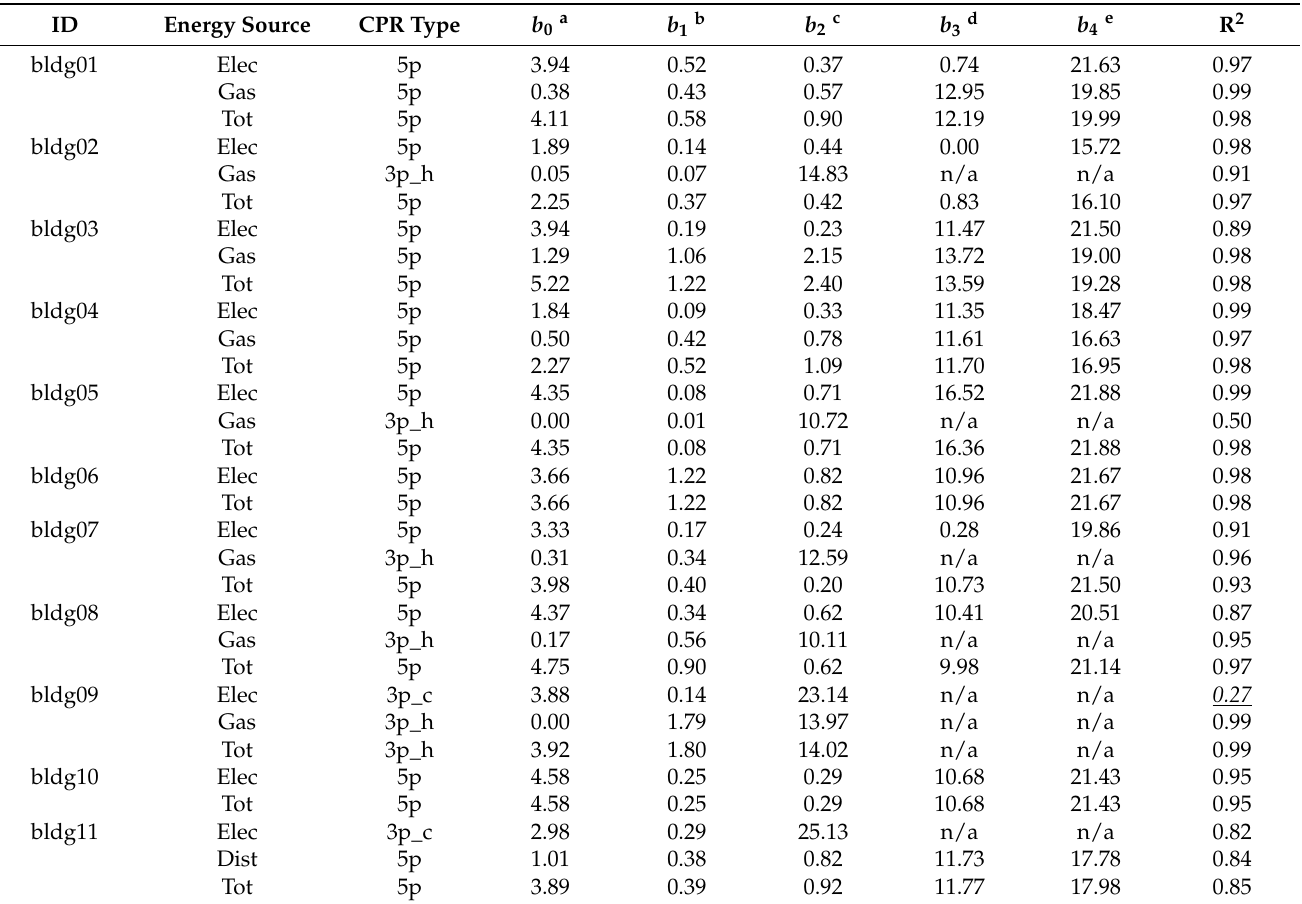
Table 3. Parameters of the best-fit model by energy